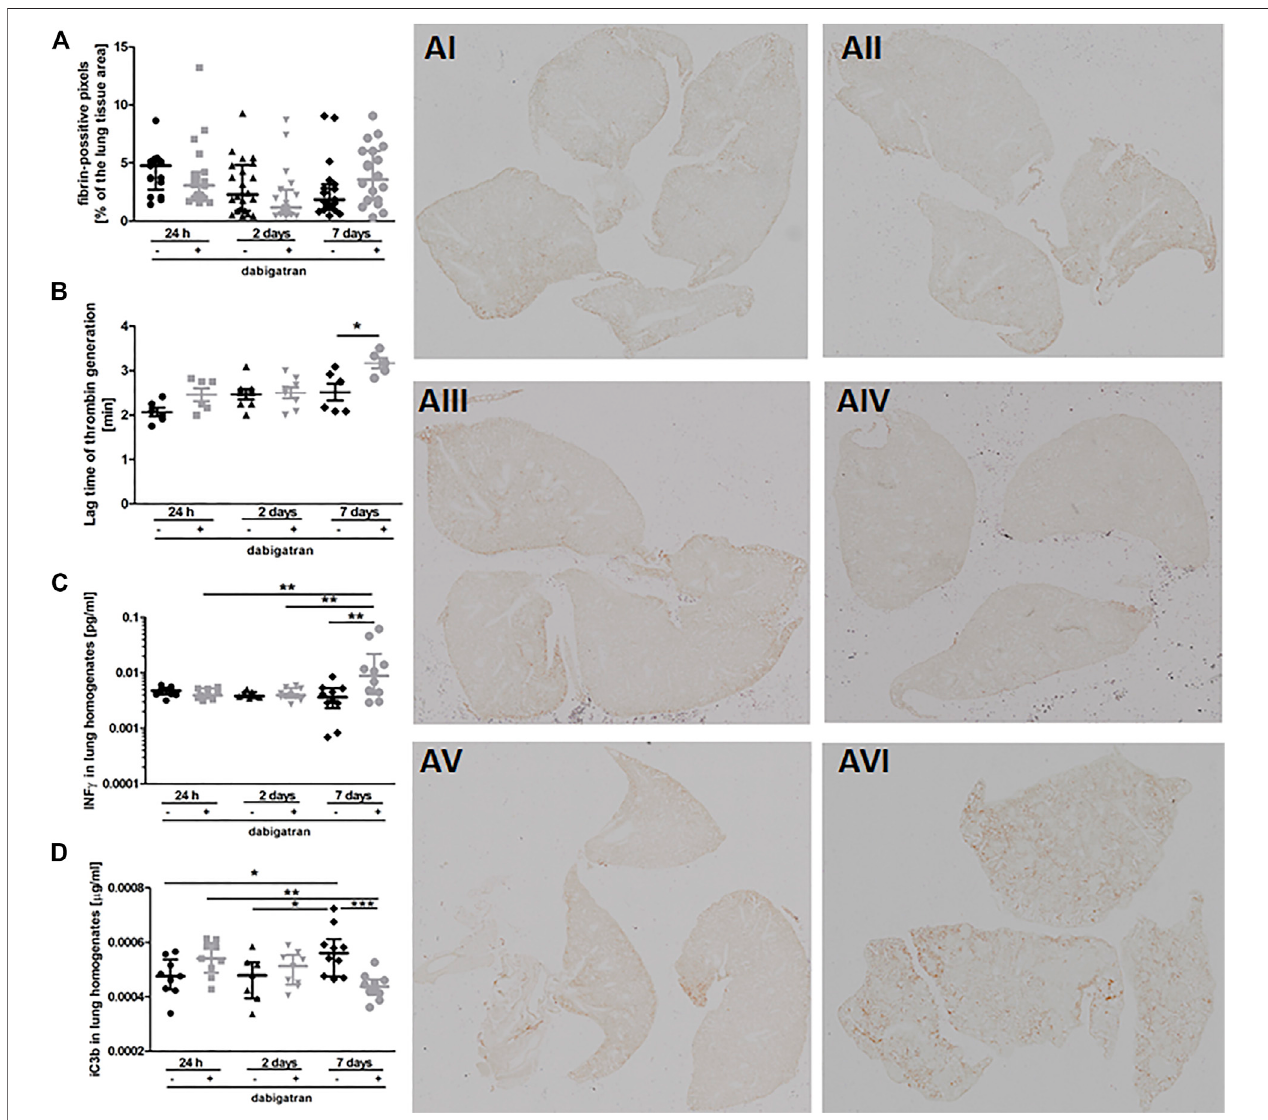
FIGURE 2 | Pulmonary fi brin deposition, lag time of thrombin generation in plasma, and innate immunity activation markers. Mice were treated with vehicle (black symbols) or dabigatran etexilate (grey symbols) as described in Section 2.5 , injected with 4T1 breast cancer cells, and euthanized at 24 h, 2 days, and 7 days after injection. (A) Lung cross-sections werestainedwithbiotin-conjugated IgG fraction of polyclonal goat antiserum tomouse fi brin antibody as described in Section 2 . The representative imagesof fi brin deposition in the lungs of4T1breast cancer cell-injected mice are given inAI (untreated, 24 hpost i.v.), AII (dabigatran-treated, 24 h post i.v.), AIII (untreated, 2 days post i.v.), AIV (dabigatran-treated, 2 days post i.v.), AV (untreated, 7 days post i.v.), AVI (dabigatran-treated, 7 days post i.v.) (200x). ScannedimagesweresegmentedusingIlastiksoftwareandcountedinImageJtodeterminethenumberofpixelscorrespondingto fi brinsignal; (B) thethrombinactivity wasdeterminedbythrombingenerationassayinmurineplasma,andexpressedasalagtimetocleavageof fl uorogenicsubstratebyfreethrombin; (C) concentrationsof interferon γ (IFN γ )and (D) complementiC3bsubunit weredetermined inlung homogenatesbyELISAkits.Statisticalanalysiswasperformed withKruskal-Wallis (A) and two-way ANOVA (B – D) tests followed by appropriate post hoc tests, and the results were presented as median ± IQR. The symbols *, **, and *** denote statistical signi fi cance at p < .05, p < .01, and p < 0.001, respectively.